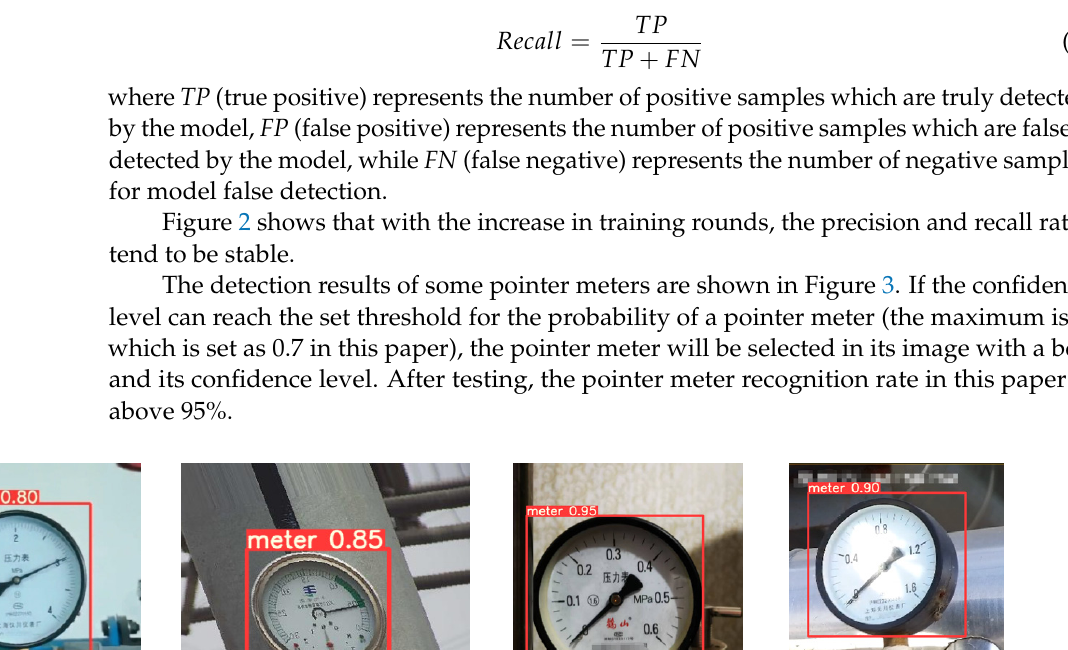
Figure 2. Precision and recall rates: ( a ) precision; ( b ) recall.